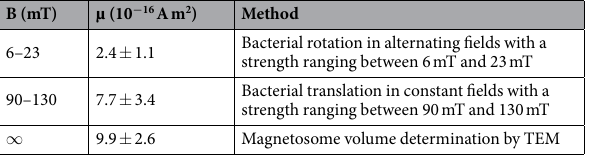
Table 1. Magnetic moments of the bacteria measured by the three different methods and the corresponding external magnetic fields. Average magnetic moments μ ( ± standard deviations) determined by the three different experimental methods: Measurement of the bacterial rotation in alternating external magnetic fields, measurement of the bacterial translation in constant external magnetic fields and determination of the magnetosome volume by TEM. The corresponding external field strengths B were in the range between 6 and 23 mT for the rotation measurements and between 90 and 130 mT for the translational measurements. The TEM measurement of the magnetosome volume provides the saturation moment for very large external magnetic